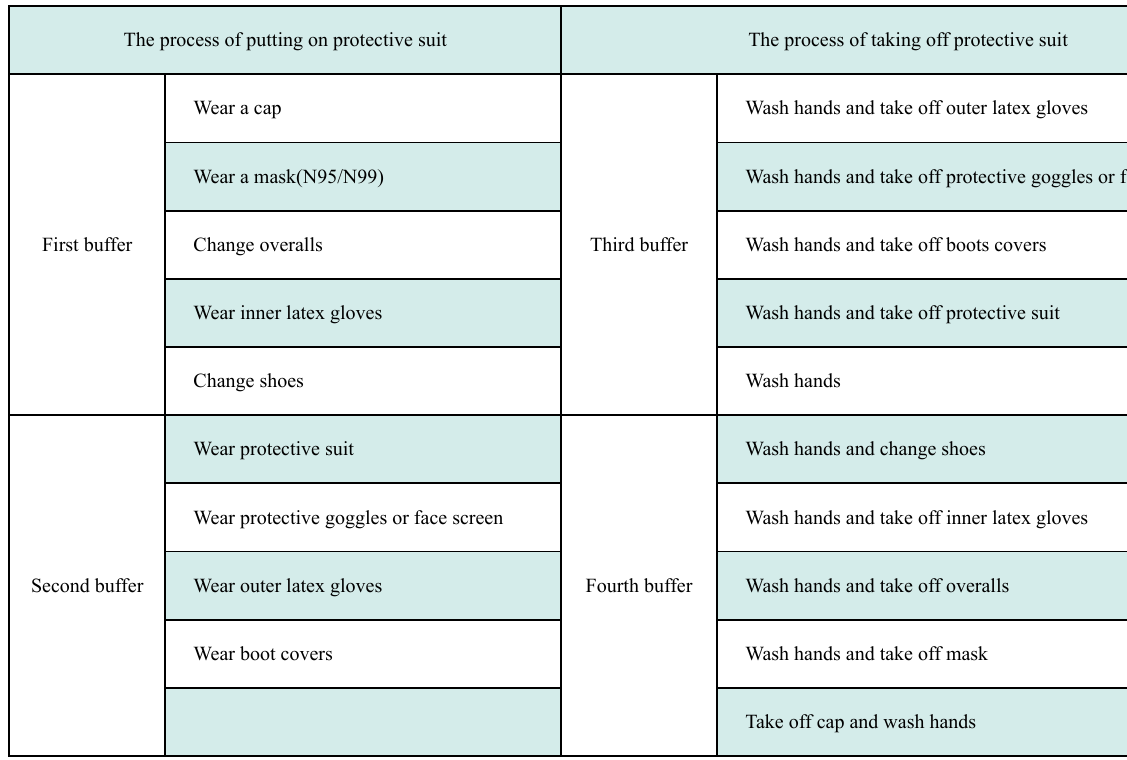
Figure 4 The procedure for putting on and taking off personal protective